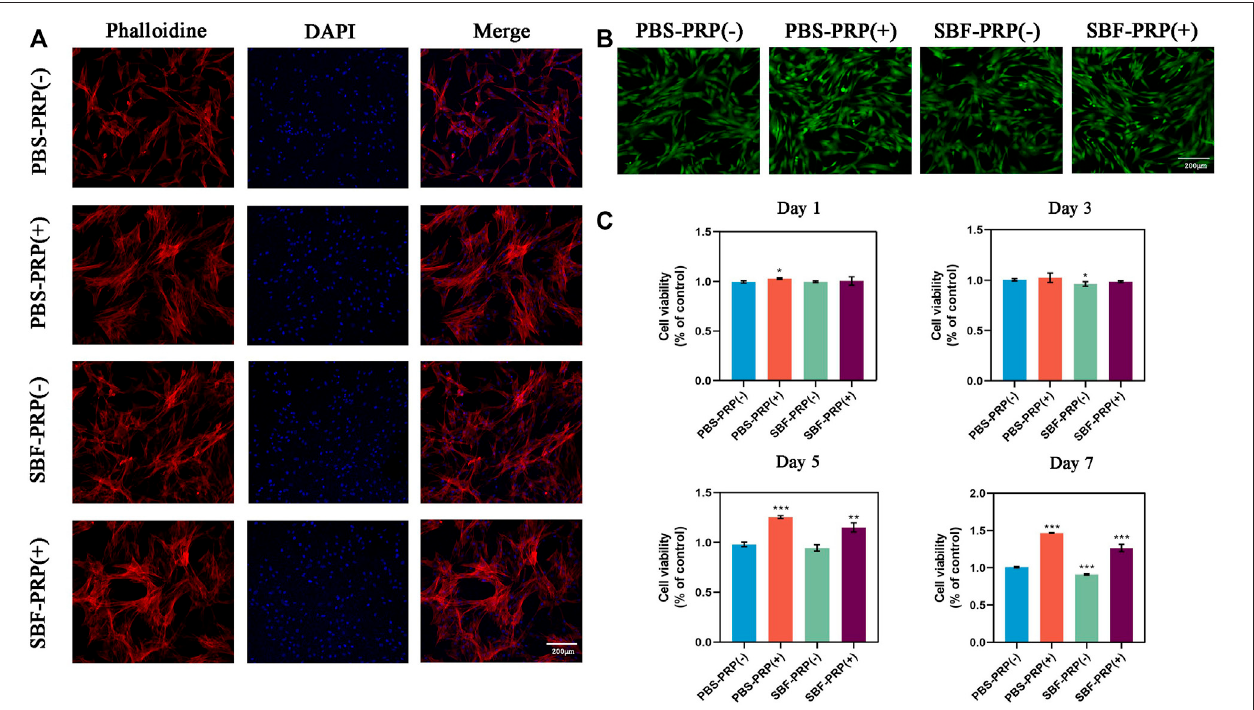
FIGURE 4 | Biocompatibility of as-prepared hydrogels. (A) Cytoskeleton of BMSCs cultivated on PBS-PRP (-), PBS-PRP (+), SBF-PRP (-) and SBF-PRP (+) hydrogels respectively. (B) Live/Dead staining of BMSCs after inoculated on four groups of hydrogels for 24 h. (C) Cell viability of BMSCs after cultivated on four groups of hydrogels for 1, 3, 5 and 7 days respectively. Asterisk indicates statistically signi fi cant differences between control and experimental group ( p p < 0.05; pp p < 0.01; ppp p <